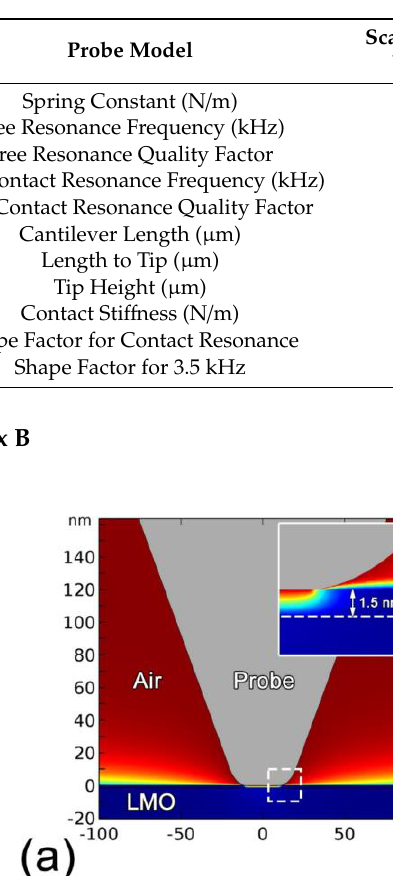
Table A1. Parameters of the probes used for the ESM measurements and corresponding calculated values of the contact stiffness and shape factor.